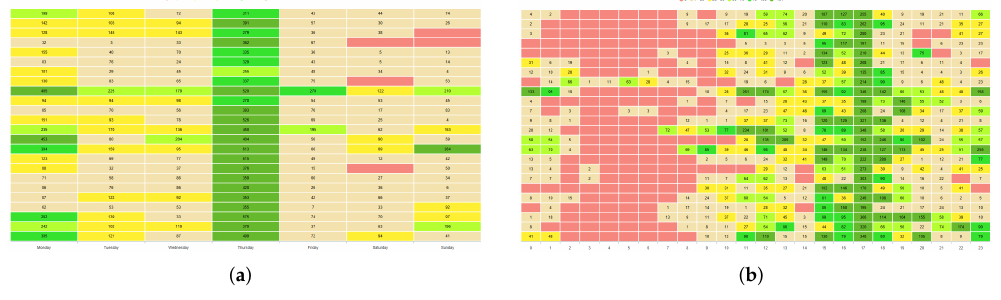
Figure 15. Blended access heatmaps. ( a ) By weekday. ( b ) By hour.